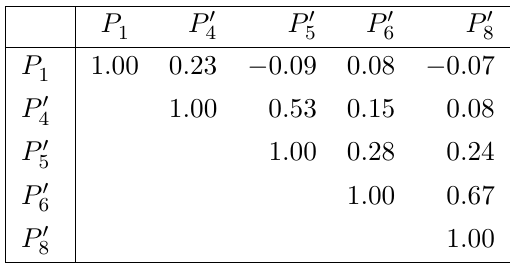
) parameters obtained for q 2 2 [1 : 1 ; 6 : 0] GeV 2 . 0